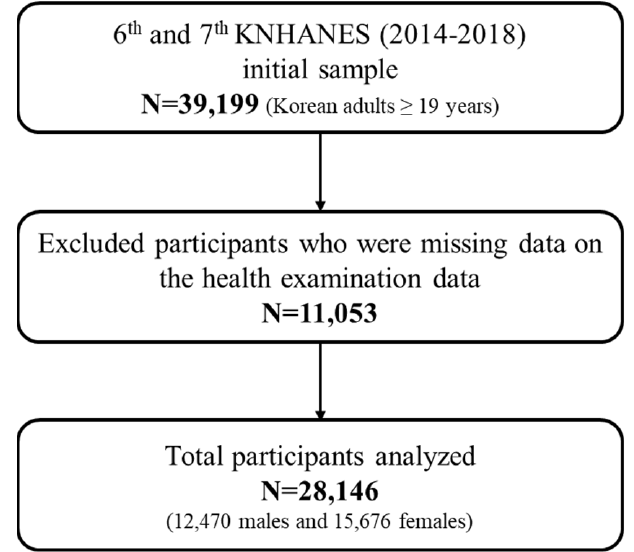
Figure 1. Flow diagram of the analytical participant selection, KNHANES.